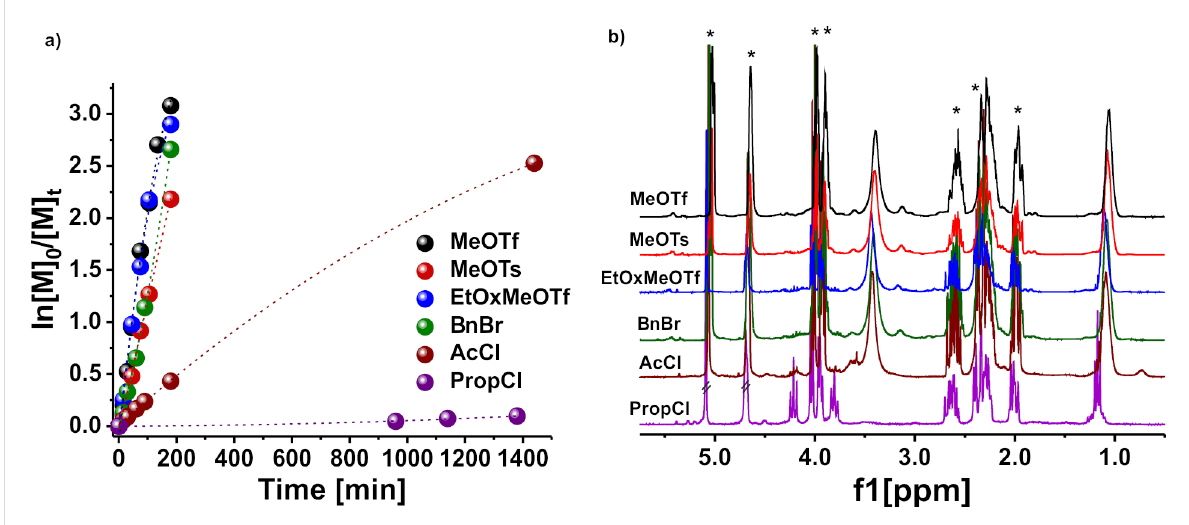
Figure 2: (a) First-order kinetic plot for the 2-ethyl-2-oxazoline ring-opening polymerization in DLG at 90 °C using 3 M monomer concentration and a monomer/initiator ratio of 50. The lines have been added to guide the eye. (b) 1 H NMR (300 MHz, CDCl 3 ) spectra of the 2-ethyl-2-oxazoline polymeri- zation initiated with methyl triflate (black), methyl tosylate (red), 2-ethyl-3-methyl-2-oxazolinium triflate (blue), benzyl bromide (green) after 3 h of incu- bation and acyl chloride (dark red), propionyl chloride (purple) after 24 h of incubation in DLG. Peaks marked with asterisks originate from residual solvent signals.